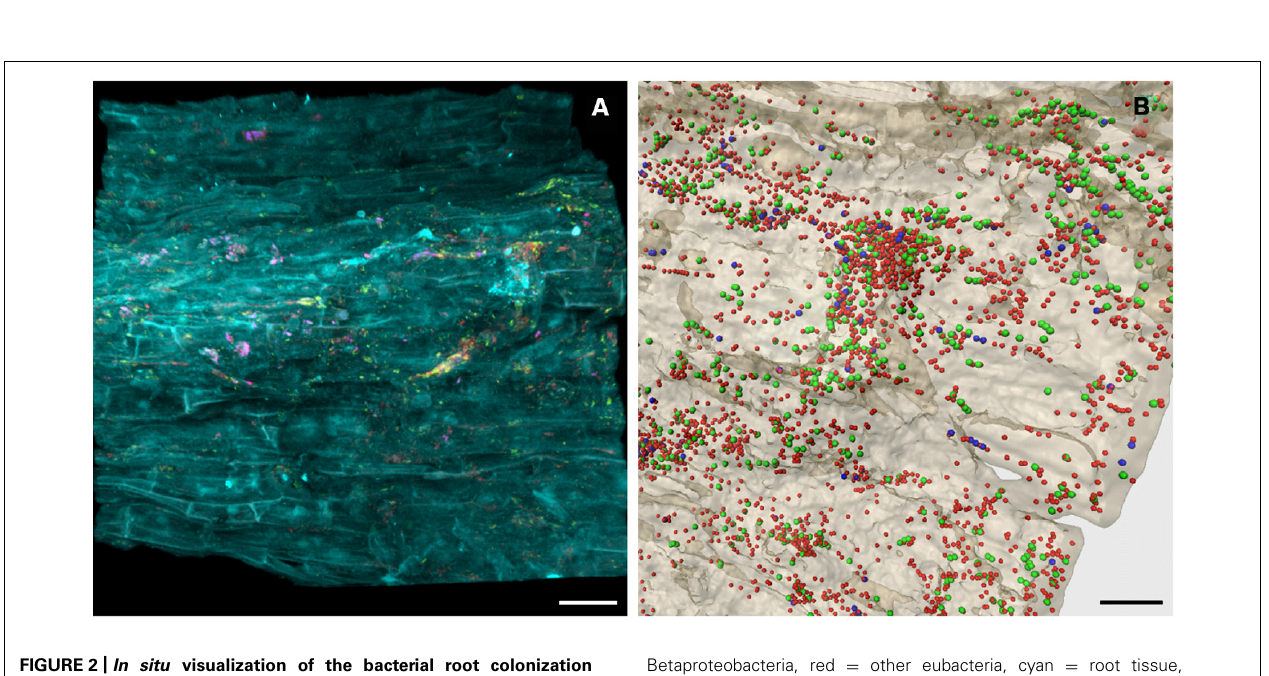
FIGURE 2 | In situ visualization of the bacterial root colonization of Matricaria chamomilla . Volume rendering (A) and three- dimensional reconstruction model (B) of confocal laser scanning microscopy stacks. (A) yellow = Alphaproteobacteria, pink =